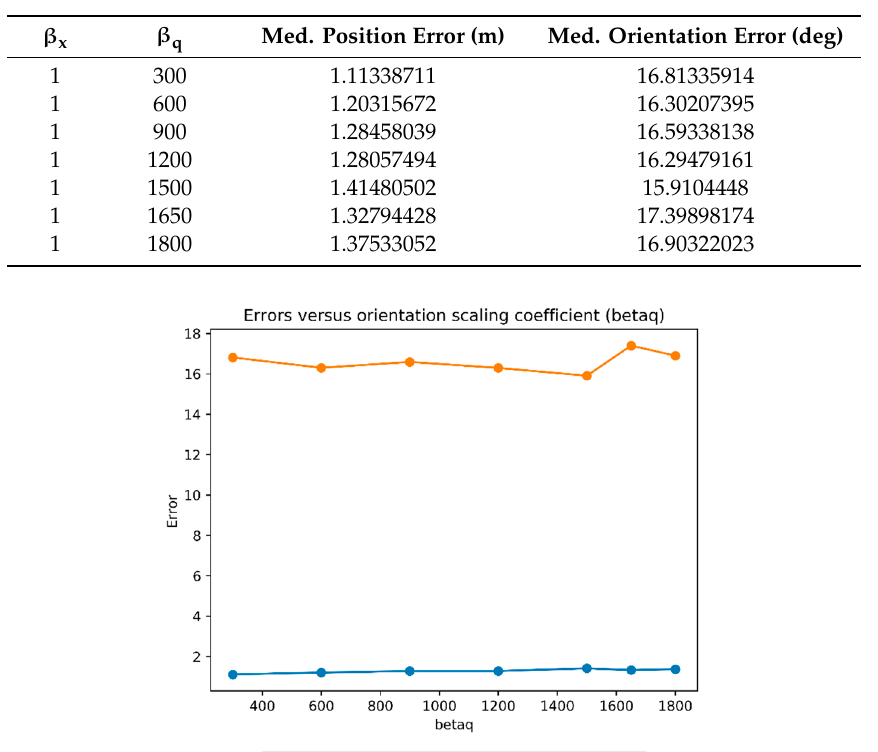
Table 6. Fine-tuning error of the weighted Euclidean-based model with various orientation scaling coe ffi cients β q .